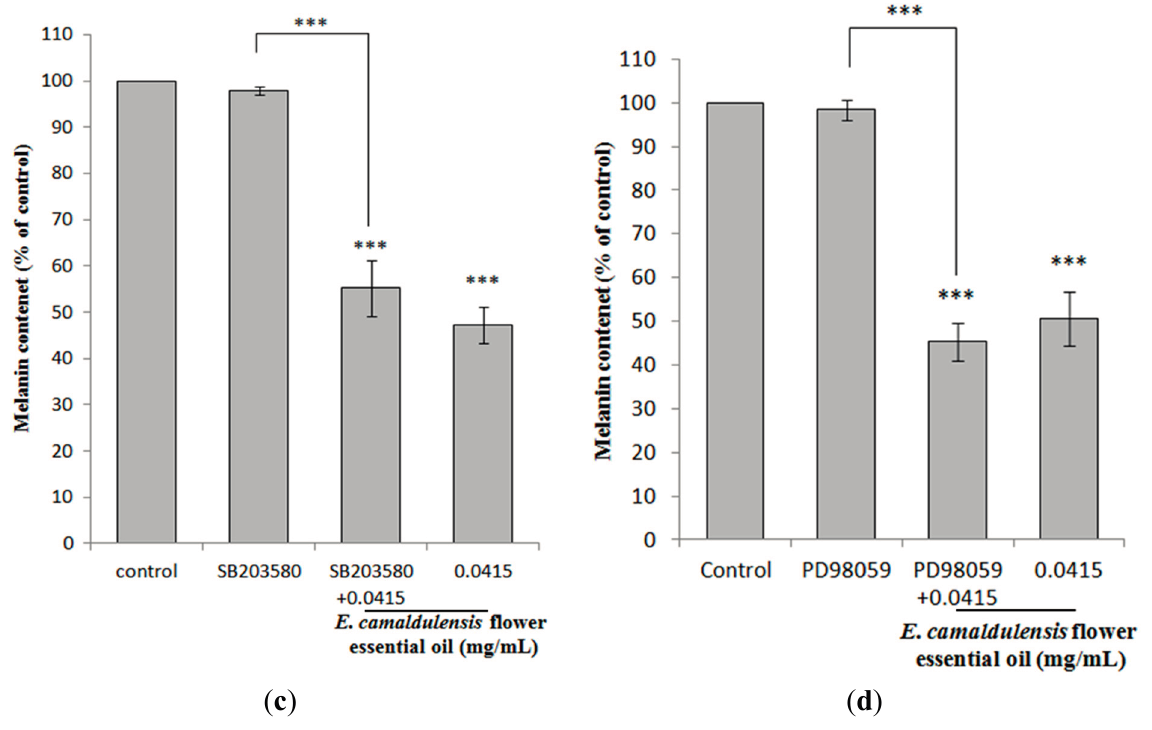
Figure 4. The effects of E. camaldulensis flower essential oil on melanin content in IBMX, PD98059-, SB203580- and SP600125-treated B16F10 cells. ( a ) The melanin content